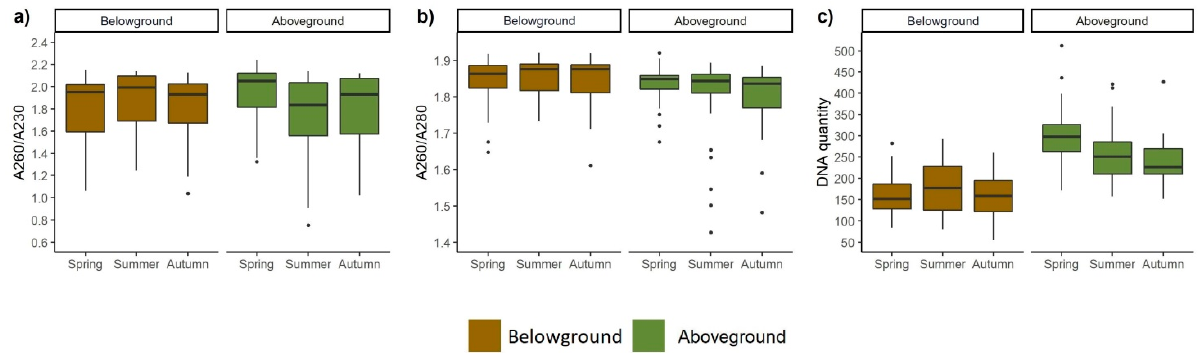
Figure 6. Comparison of quality ( a , b ) and yield ( c ) of DNA extracted from various meadows sampled along vegetation season. The horizontal line denotes the median values, the box indicates the first and third quartiles, and the points indicates outliers.